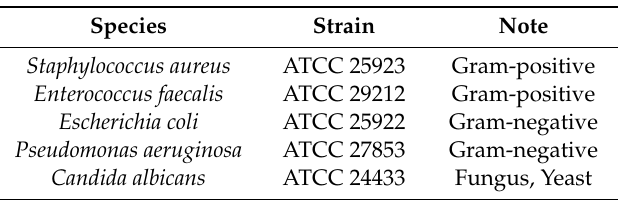
Table 1. A list of the strains that were used to test the antimicrobial activity of the synthesised quaternary ammonium